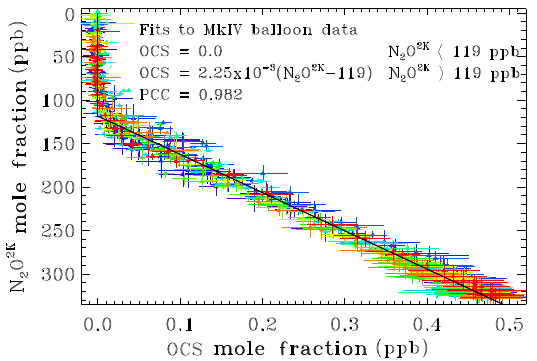
Figure A1. The MkIV balloon OCS–N 2 O 2K relationship color- coded by year (blue: 1991; green: 2001; red: 2011) and the fitted straight-line segments (black). The line fitted to the N 2 O 2K > 119ppb data (417 points) has a gradient of 0.225 ± 0.001, an intercept of N 2 O = 119 ± 4ppb, and a Pearson correlation coef- ficient of 0.982.